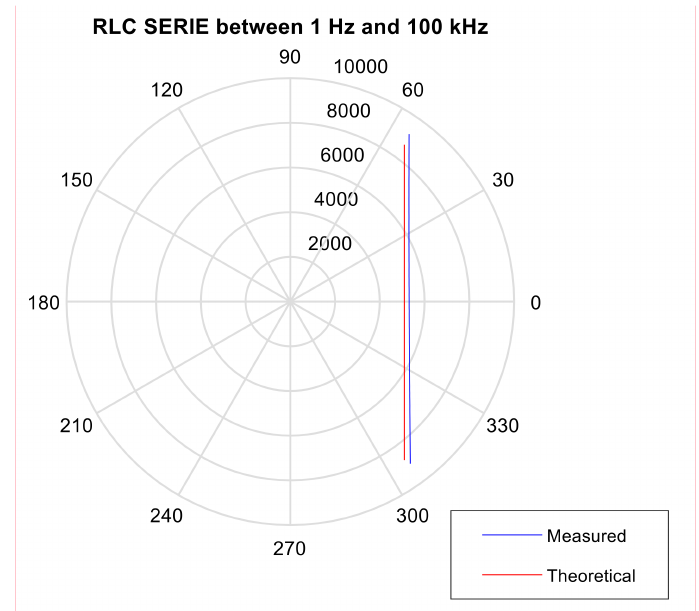
Figure 2. Polar diagram of the test with SERIAL RLC circuit between 1 Hz and 100 KHz. The blue values are measured and the red ones are theoretical.